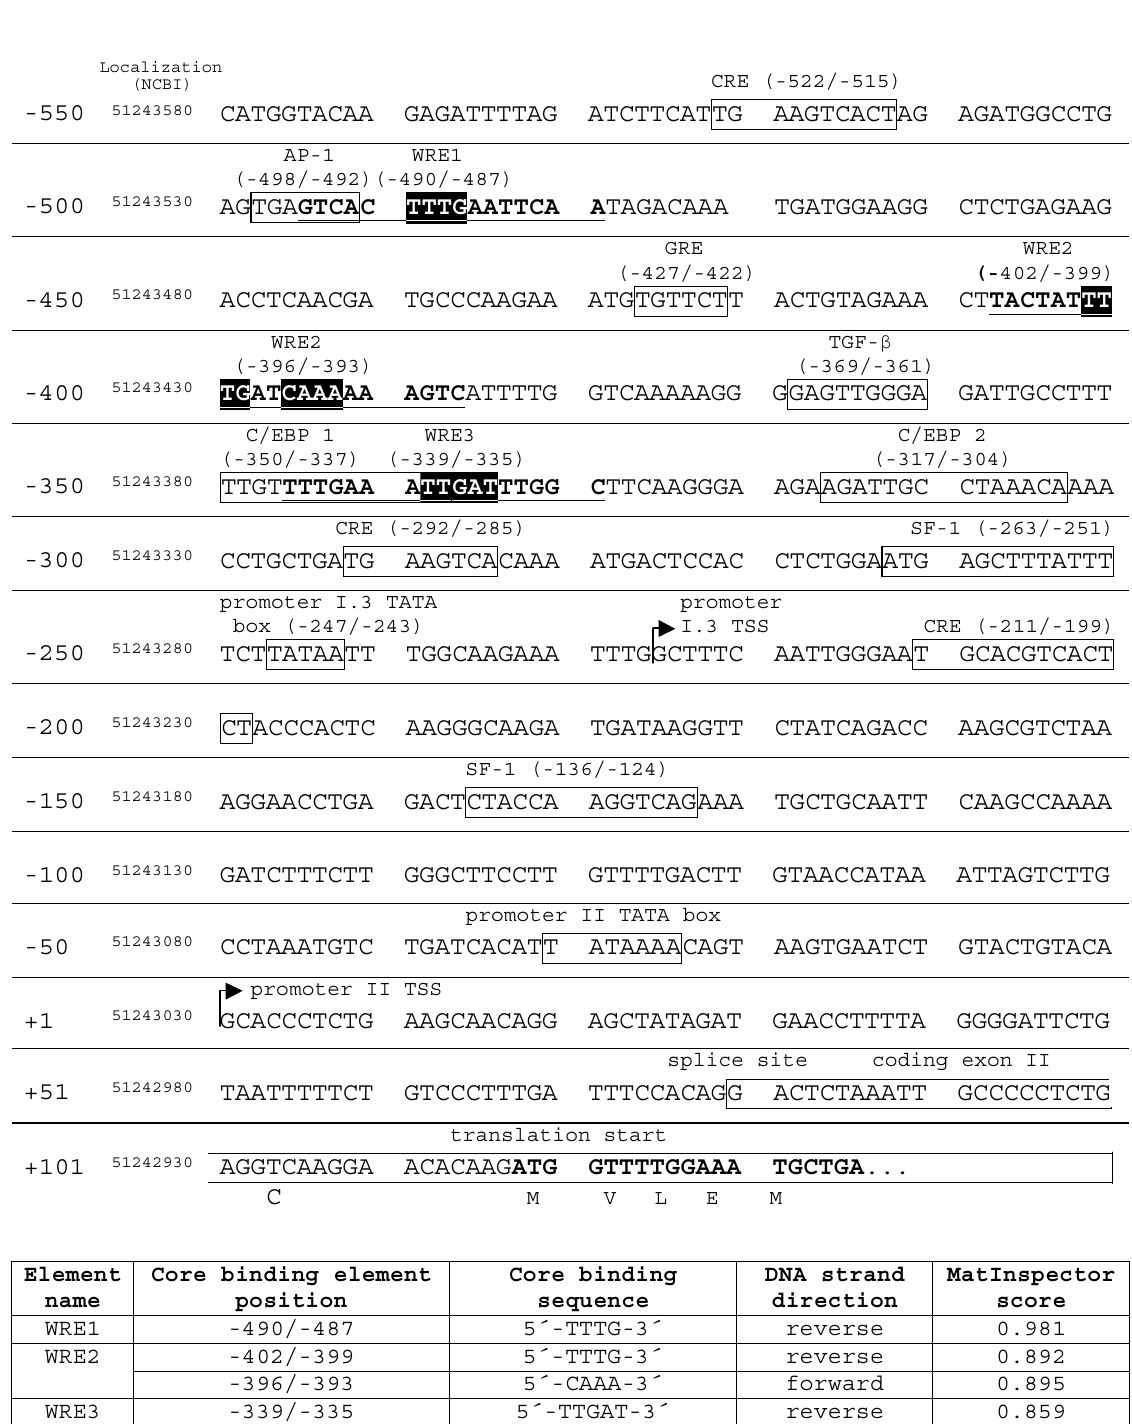
Figure 3. Transcription factor binding sites and Wnt response elements (WRE) in the aromatase promoter I.3/II. MatInspector (Genomatix) database searches revealed three putative WREs in the aromatase promoter I.3/II region (GenBank Nc_000015.10 chromosome 15 reference GRCh38 primary assembly). The core binding element positions are indicated with respect to the promoter II transcriptional start site (TSS). In addition, their genomic localization is given. WRE core binding elements are highlighted in black; full-length WRE sequences are in bold type and underlined. WRE2 combined two core binding sequences in forward and reverse direction, respectively. WRE search results (lower table) were evaluated by MatInspector´s specific matrix similarity score. The higher the score, the higher the sequence identity with the ideal WRE sequence (maximum score 1). The promoter elements in boxes are derived from a review of Chen et al.